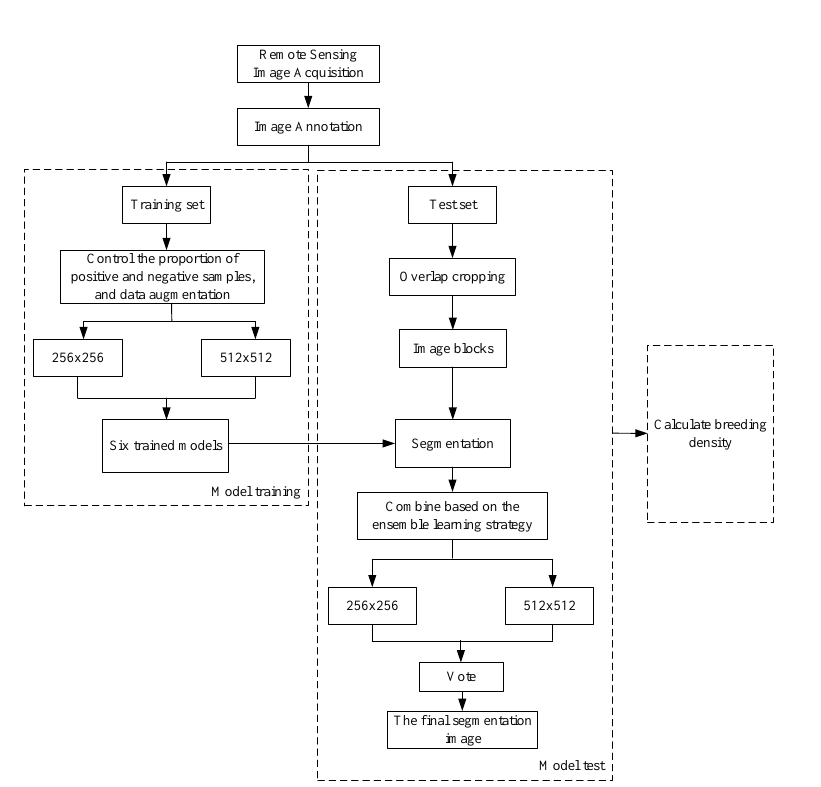
Figure 5. The proposed overall